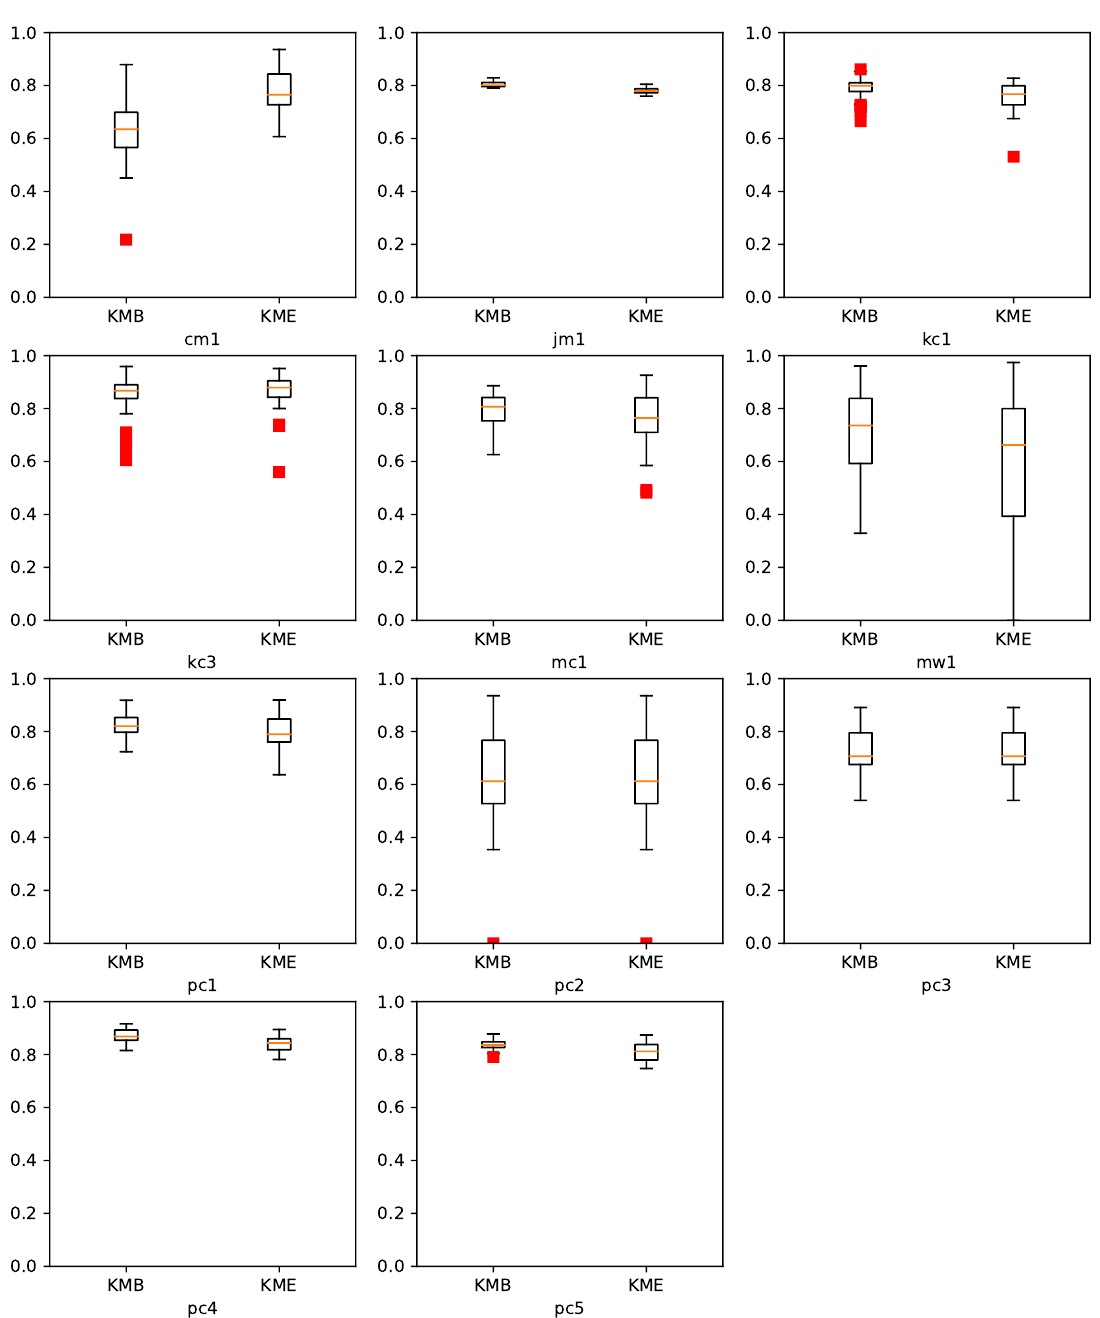
Figure 11. Boxplot representing the G-mean of KMB and KME for NASA